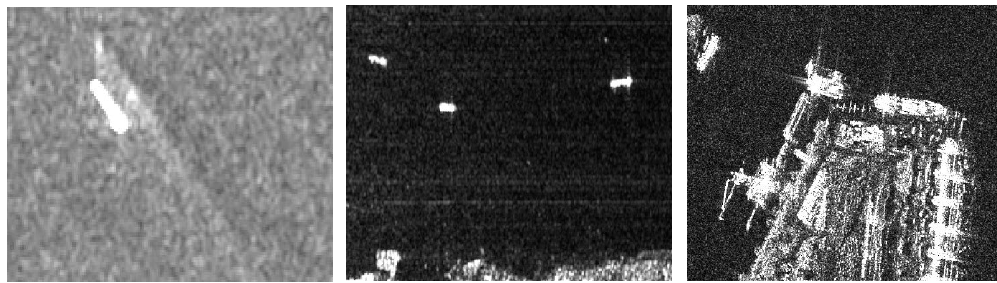
Figure 5. Some examples of SSDD. The first line shows ships in complex scenes; the second line shows ships in open sea area; the third line shows ships with different resolutions.